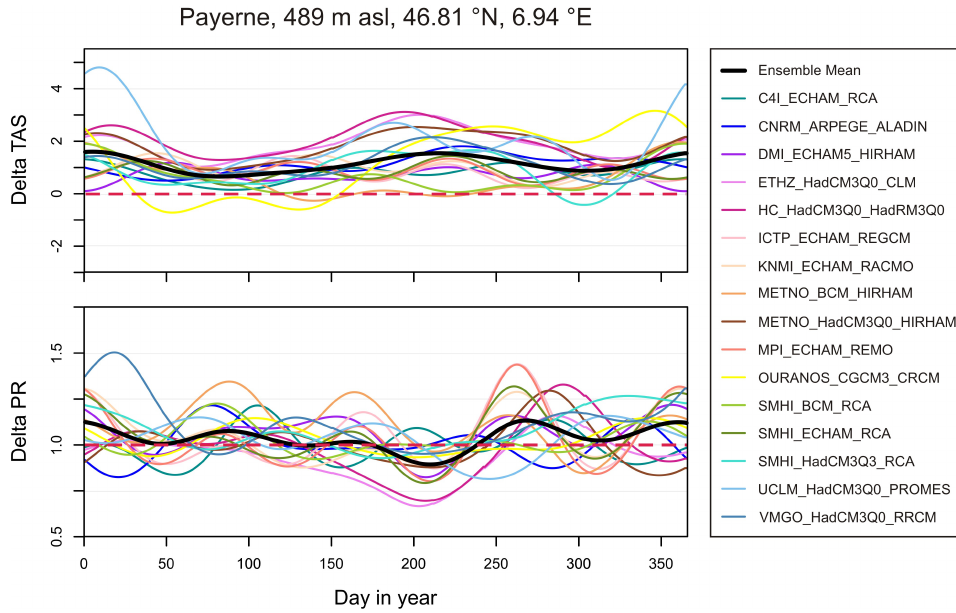
Fig. 4. Annual cycle of the Delta Change Signal for precipitation (PR) and temperature (TAS; Bosshard et al., 2009) using the example of Payerne. The abbreviations in the legend denote the model chain of each RCM as INSTITUTION GCM RCM. For all model chains the SRES emission scenario A1B (IPCC, 2000) was chosen, except for C4I ECHAM RCA where it was